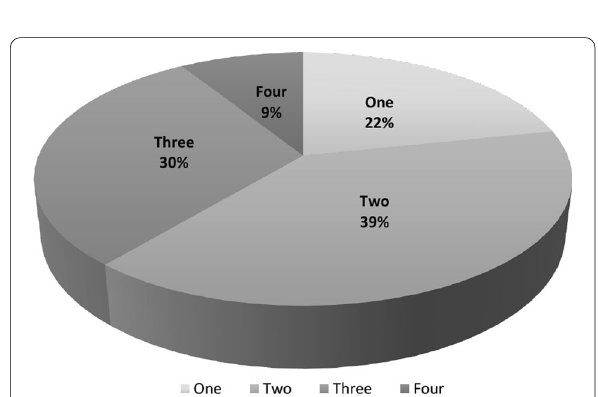
Figure 2 Number of medications used to treat neuropathic pain per patient ( N =